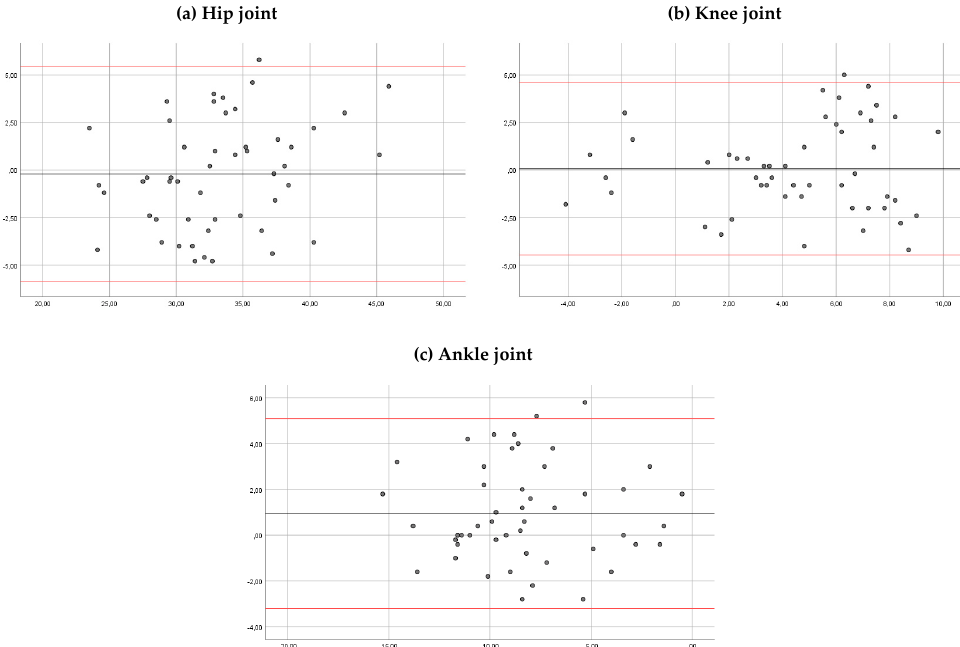
Figure 4. Bland–Altman plots comparing results between sessions of measurements (for observer 1) for the hip ankles ( a ), knee angles ( b ) and ankle angles ( c ). Bias (black line) and limits of agreement (red lines) are shown for each parameter. The mean score is plotted on the x -axis, and the difference between sessions (mean of the differences) is plotted on the y -axis (mean difference ± 1.96 SD).